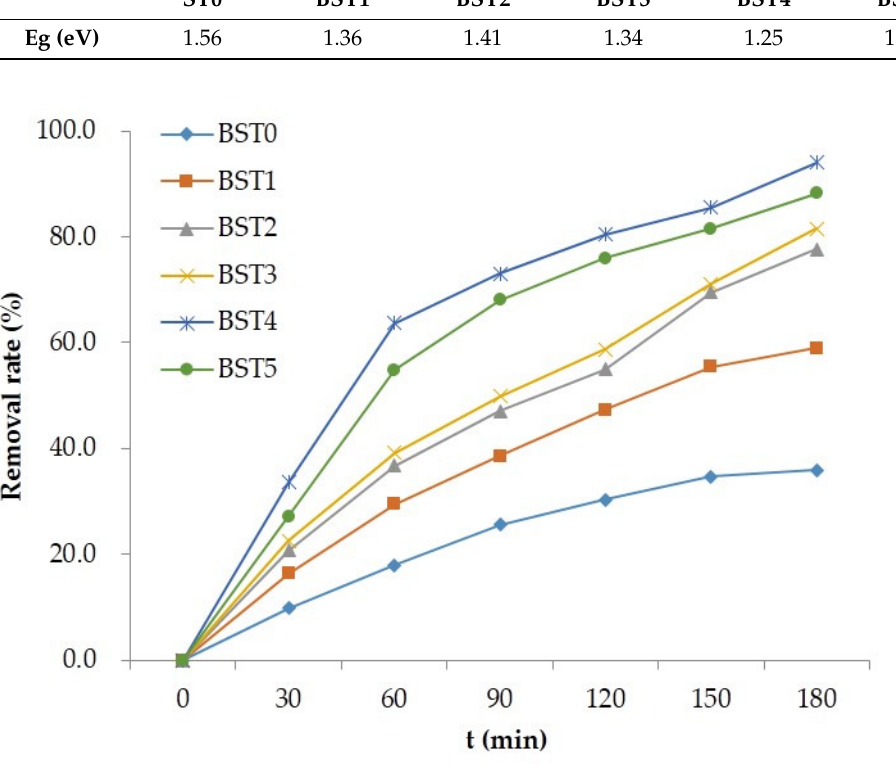
Figure 9. The removal rate of gas Formaldehyde in different Bi-doped wood samples. Table 2. The band gaps of Bi-Ti/Si-X composite films.